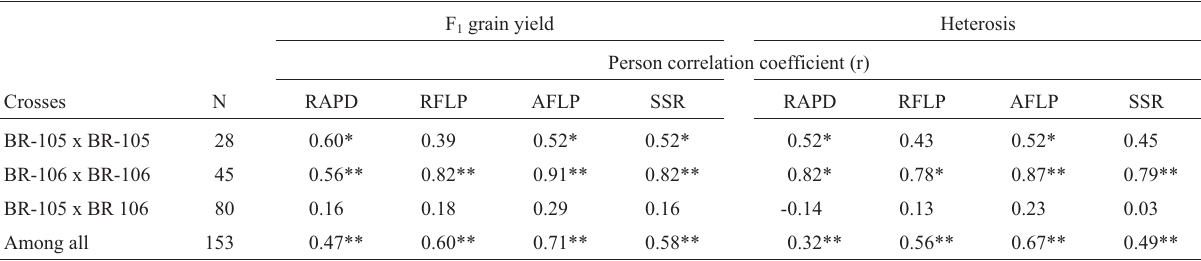
Table 4 - Pearson correlation coefficient (r) between genetic distance (GD) and F 1 grain yield and heterosis for different maize crosses within and between heterotic groups as calculated using data from random amplified polymorphic DNA (RAPD), restriction fragment length polymorphism (RFLP), amplified fragment length polymorphism (AFLP) and simple sequence repeat (SSR)